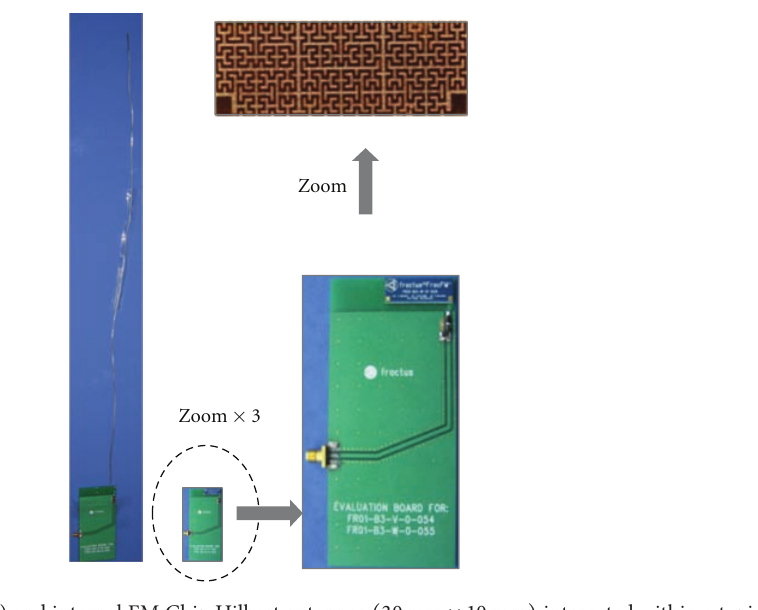
F 10: External wire (75cm length) and internal FM Chip Hilbert antennas integrated within a typical